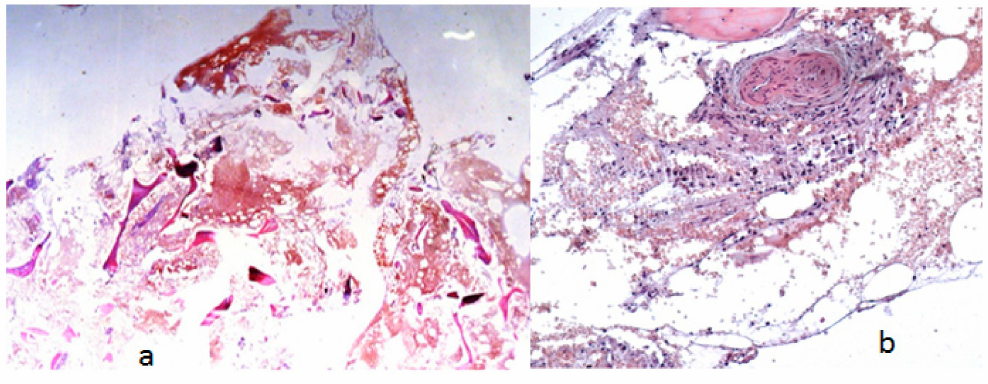
Figure 5. A bone specimen of a lesion over the left femur obtained at an open biopsy. Overview bone biopsy (H&E staining): ( a ) Via original magnification, the histopathology revealed trabecular fragments and large cavernous lymph spaces. ( b ) Another bone biopsy at higher magnification showed lymphatic malformation with ectatic lymph vessels. a. magnification of × 100. b. Higher magnification ( ×